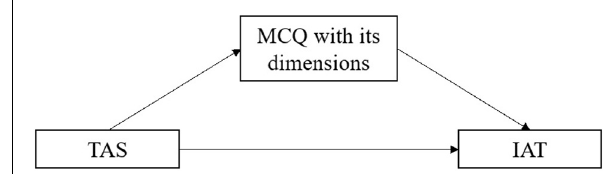
FIGURE 1 | Measurement